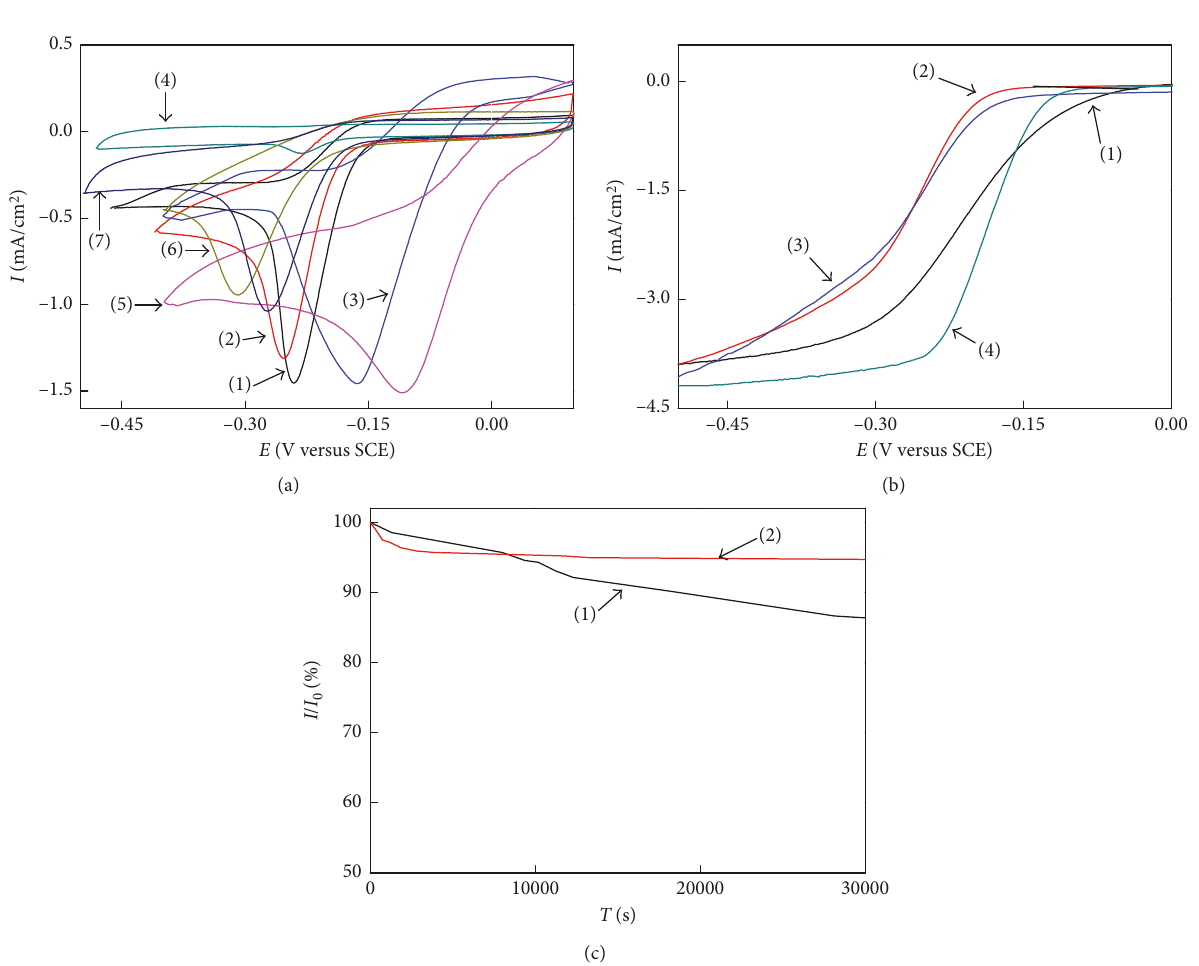
Figure 4: Electrochemical measurement of support and catalysts. (a) CV in O 2 or N 2 -saturated 0.1MKOH solution with a scan rate of 5mV · s − 1 : (1) N/S-CNTs; (2) N/S/F-CNTs-2; (3) N/S/F-CNTs; (4) N/S/F-CNTs in N 2 ; (5) 20% Pt/C; (6) MWCNTs; (7) N-CNTs. (b) LSV in O 2 -saturated 0.1MKOH solution at the rotation rate of 1600rpm with a scan rate of 10mV · s − 1 : (1) 20% Pt/C; (2) N/S/F-CNTs-2; (3) N/S-CNTs; (4) N/S/F-CNTs. (c) The current–time chronoamperometric response of catalysts: (1) 20% Pt/C; (2)